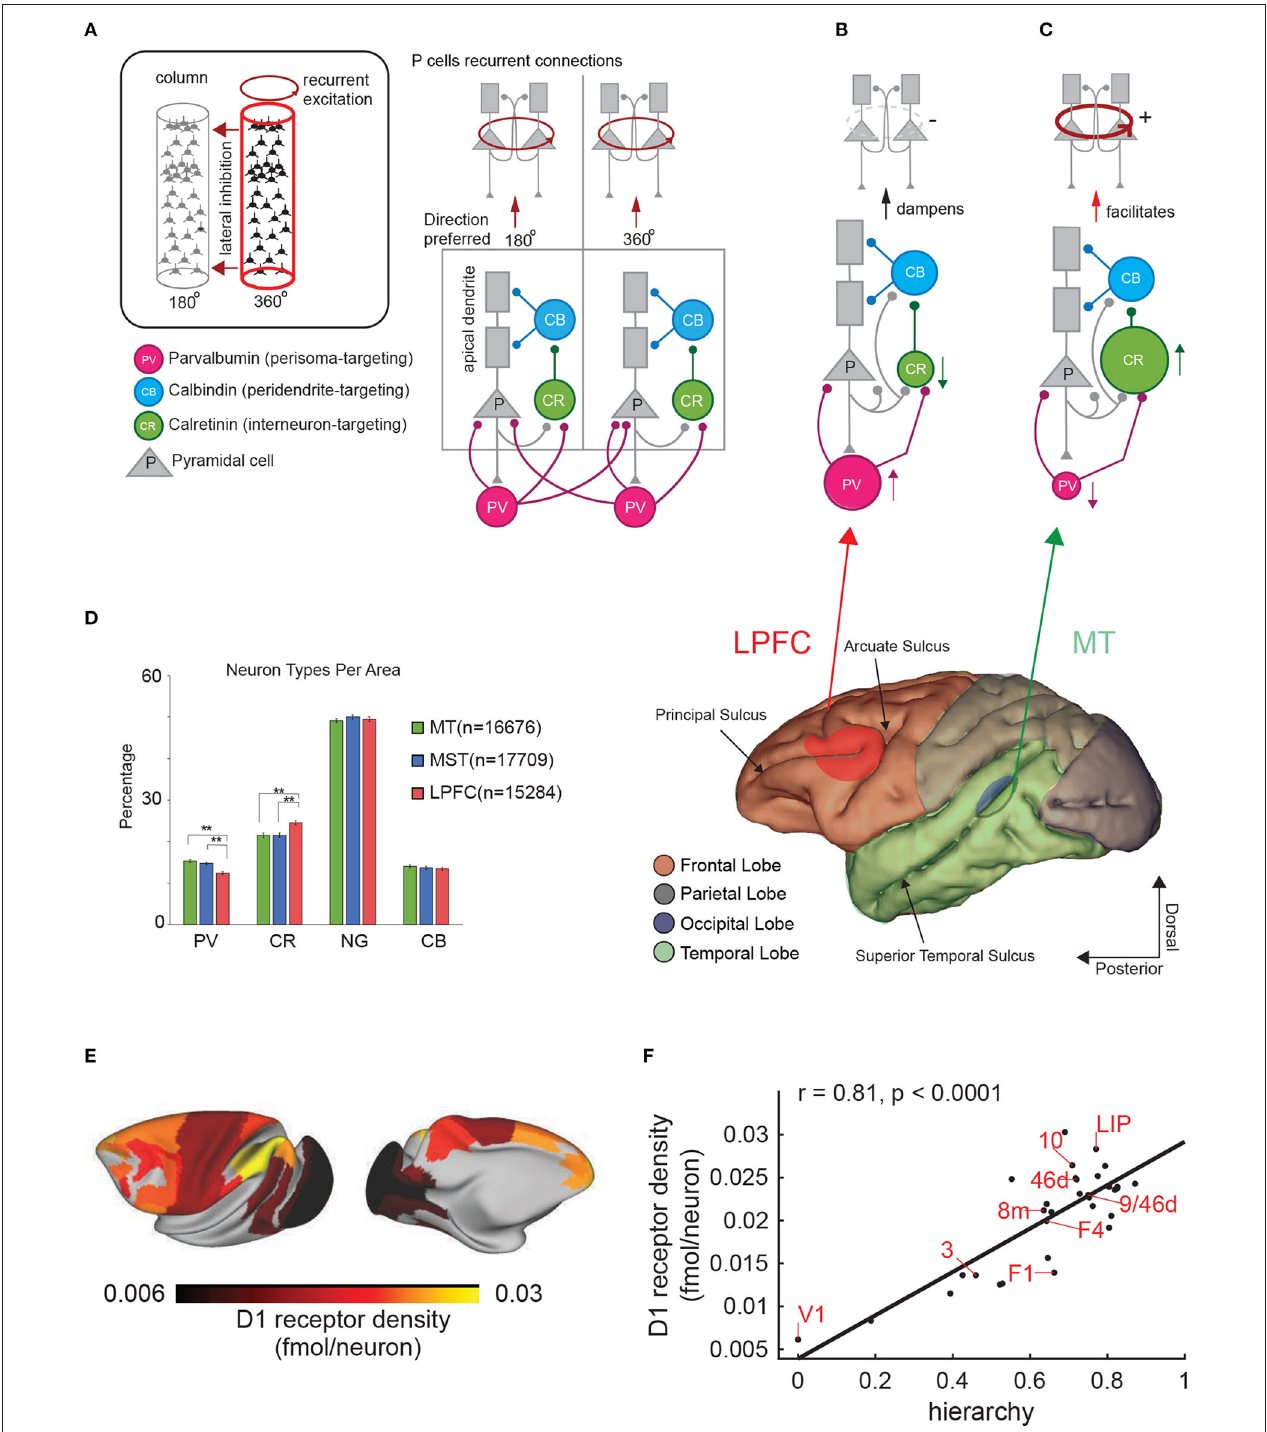
FIGURE 4 | Cortical architectures for perception and working memory. (A) Diagram showing the structure of two nearby cortical columns and the four main cell types (see inset). Observe pyramidal cells have at least two distinct compartments, the apical (distal) dendrites (gray rectangles) and the cell body. (B,C) different architectures based on the proportion of CR and PV interneurons and the ability to produce persistent firing. Lower panel shows a side view of the macaque brain and the different lobes in different colors. (D) Percentages of the 4 main cell types in areas MT, MST, and the LPFC (from Torres-Gomez et al., 2020). Distribution of Dopamine D1 receptors in the macaque brain. The color scale indicates the receptor density. (F) Correlation between position of a brain area in the hierarchy of visual processing and D1 receptor density. Each data point represents a brain area. The correlation coefficient and associated p- value are indicated courtesy of Froudist-Walsh et al. (2020). (E) D1 receptor density across the macaque cortex.